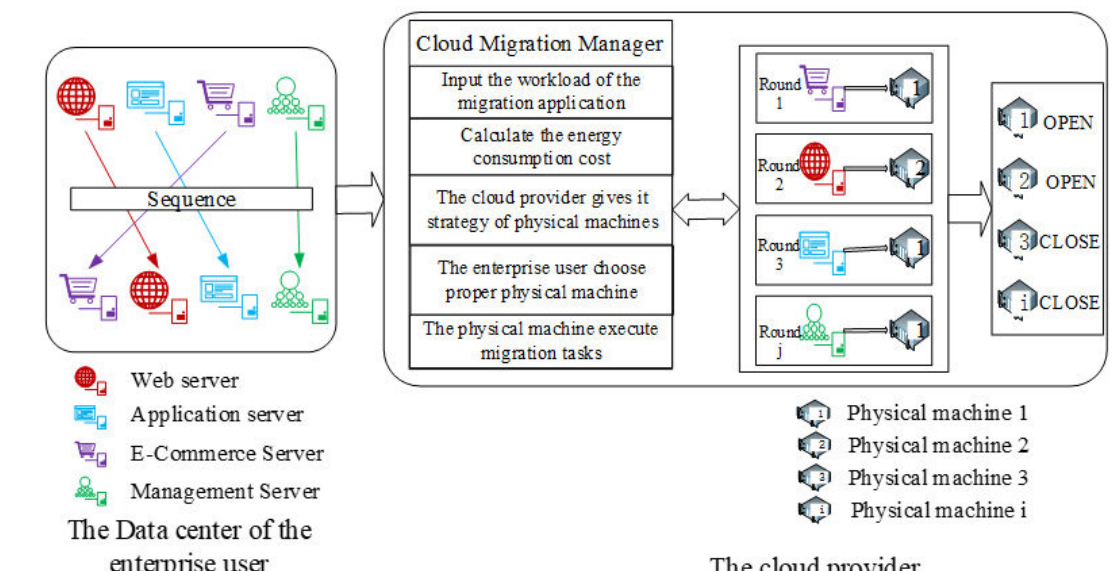
Figure 4. Cloud migration architecture and